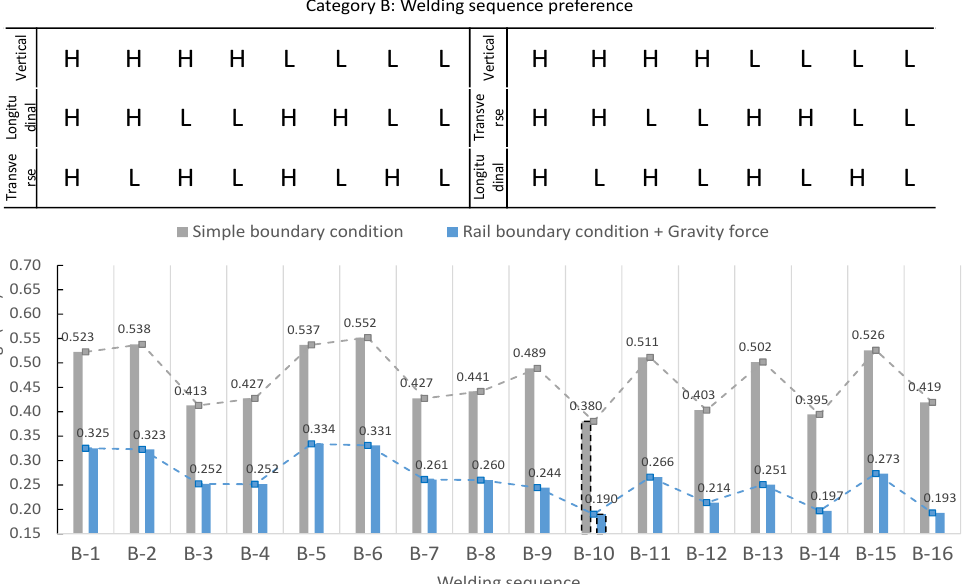
Figure 13. 𝐴 𝑑𝑖𝑠𝑡𝑎𝑛𝑐𝑒 of Category B under two different boundary condition.